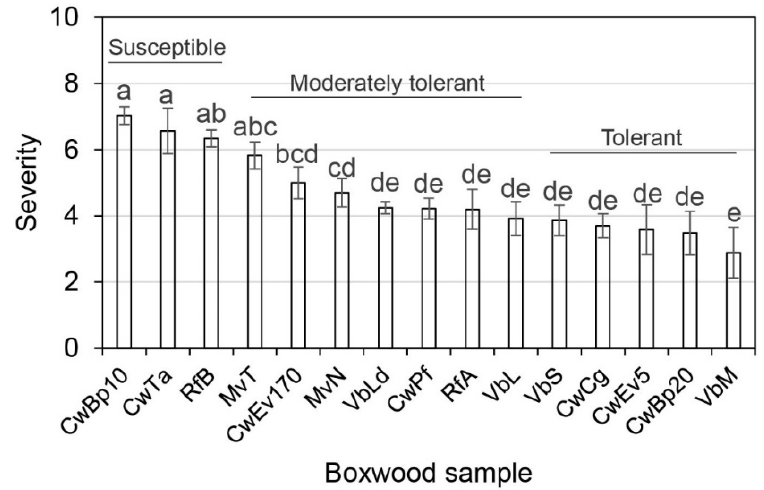
Figure 1. Differential blight tolerance of English boxwood twigs collected from three historic gardens in Virginia—Colonial Williamsburg (Cw), George Washington’s Mount Vernon (Mv) and River Farm (Rf), and the Virginia Tech’s research farm in Virginia Beach (Vb). Each column represents the mean disease severity topped by a standard error bar ( n = 6). Columns topped with a shared letter do not differ according to the least significant difference test at p = 0.05.